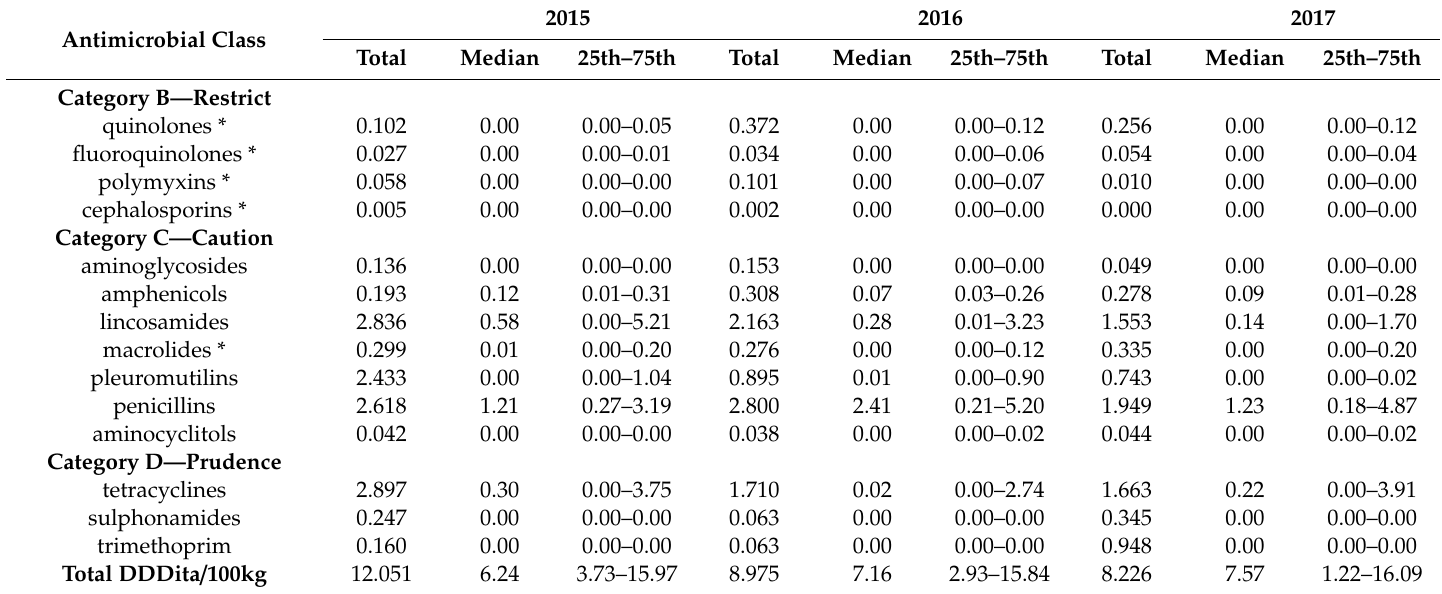
Table 1. Defined daily doses per animal (total and median DDDita / 100kg with 25th–75th percentile) administered in 2015–2017 in 36 Italian finishing